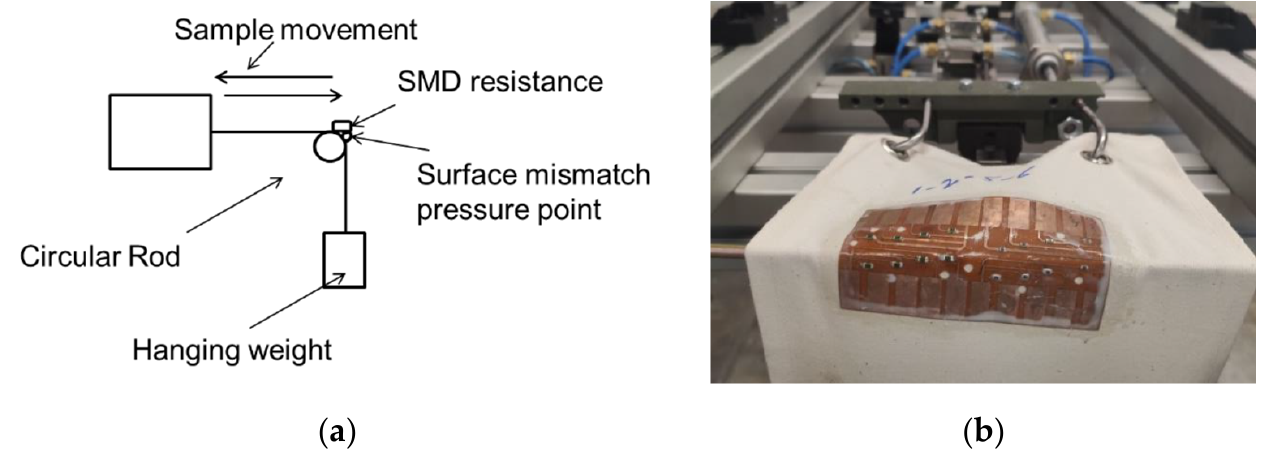
Figure 3. ( a ) Schematic presentation of the sample movement in bending test. ( b ) Bending machine with